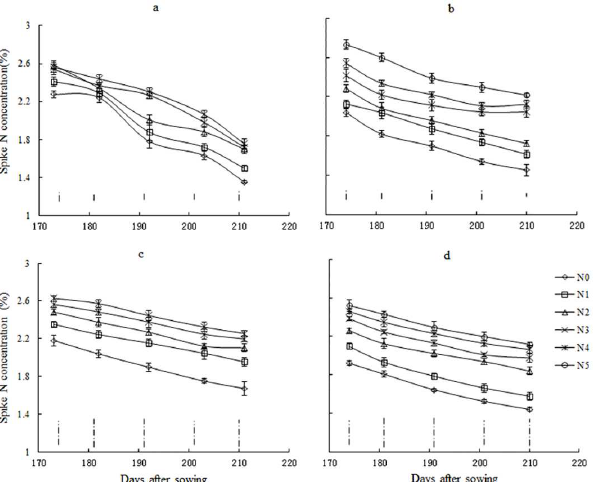
Fig 2. Changes in winter wheat spike N concentration with time under different N application rates in the 2009 and 2011 seasons. a: 2009–2010 NM13, b: 2010–2011NM13, c: 2009–2010YM16, d: 2010– 2011 YM16. Data are presentedas days after sowing. The vertical bars represent standard error of the mean value on each samplingdate. The vertical dotted bars without line end represent LSD values ( P < 0.05) on each